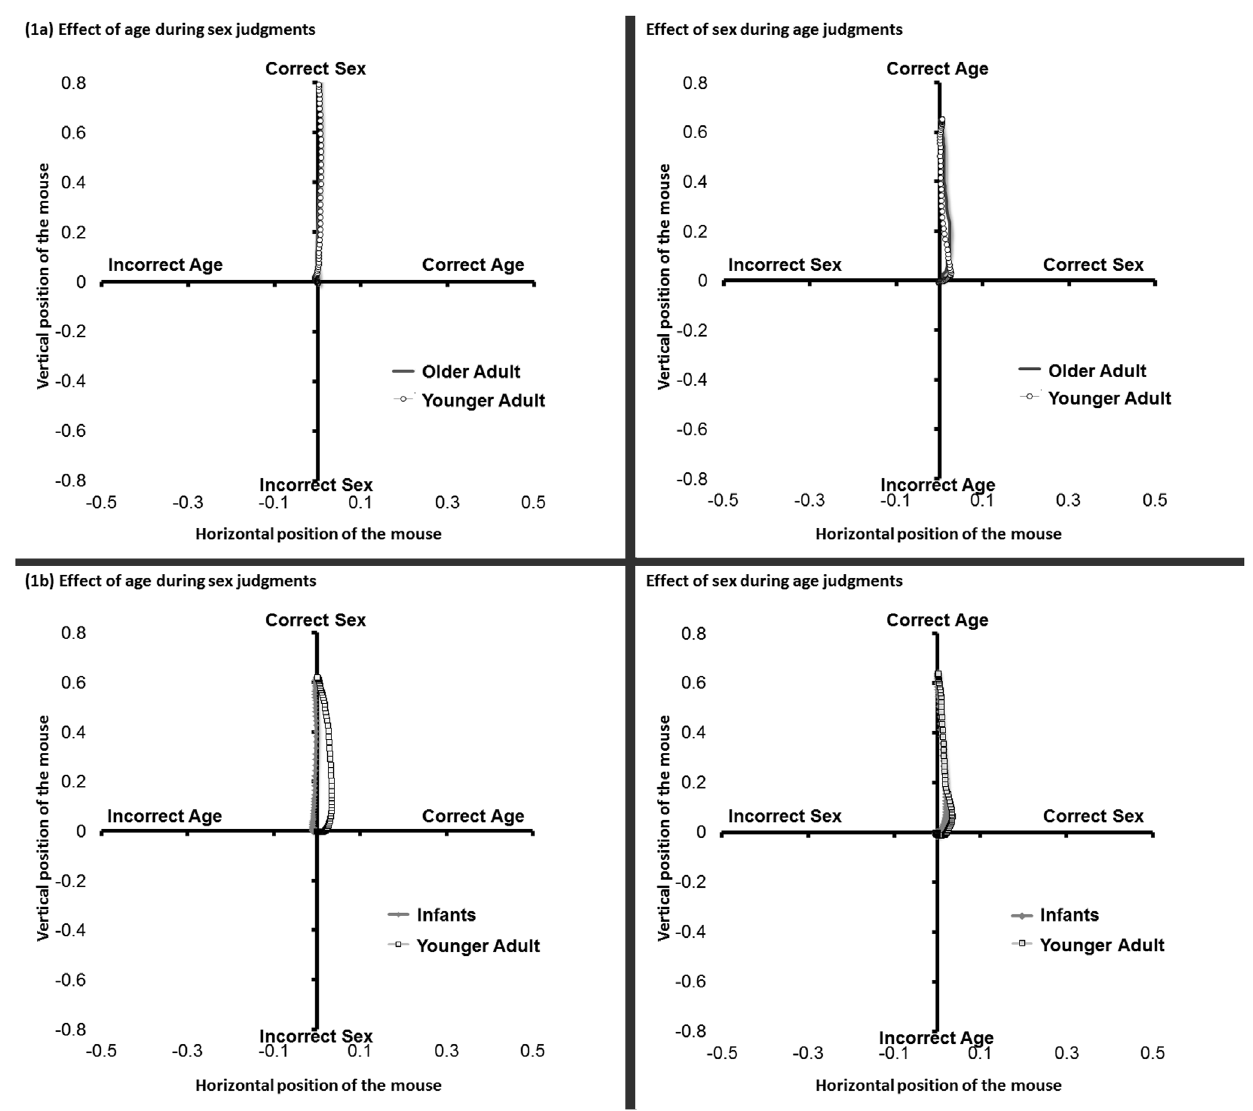
Figure 2. Top: Graphical display of the computer mouse trajectories when categorizing older adults and younger adults faces as a functions of either their sex (left) or their age (right). Inspection of these trajectories reveals: 1) no influence of the relevant age category during sex categorization of both older and younger adult faces; 2) the influence of the relevant sex category during age categorization. Bottom: Graphical display of the computer mouse trajectories when categorizing infant and younger adults faces as a functions of either their sex (left) or their age (right). Inspection of these trajectories reveals: 1) the influence of the relevant age category during sex categorization of infant but not younger adult faces; 2) the influence of the relevant sex category during age categorization of both younger adult and infant faces, with a greater influence when categorizing younger adult faces. doi:10.1371/journal.pone.0084677.g002 t (20)= 3.16, p , 0.005, indicating more attraction towards the relevant sex categories when categorizing younger-adults com- pared to infant faces (Figures 2 & 3). Mouse trajectories for sex- categorization trials, however, only showed an attraction toward the relevant age category when infant faces were presented. This was indicated by a significant interaction between judgment type and target age on MD [ F (1, 20) =10.074, p , 0.005]. Further analysis found MD for infant faces ( M = 0.041, SE = 0.015) being significantly more positive (in the direction of the relevant age category) than zero, [ t (20)= 2.68, p , 0.014] but MD for younger- adult faces ( M = 2 0.012, SE = 0.013) not being significantly different than zero [ t (20)= 0.95, p , 0.36]. A marginally significant difference was observed between the infant and younger-adult